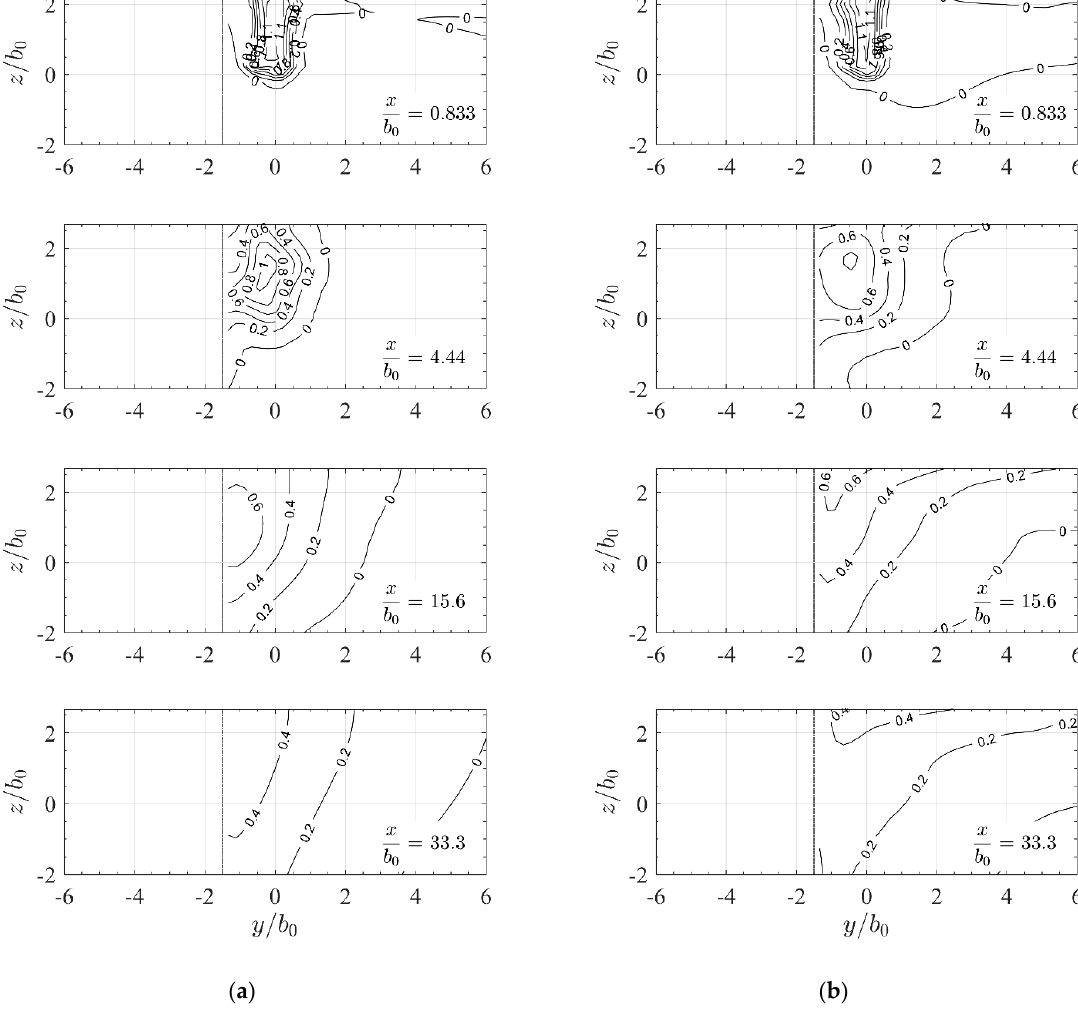
Figure 15. Slot jet with inhomogeneous approach flow and wall distance equal to b 0 showing isolines of the normalized, time-averaged, streamwise velocity component in yz-sections with relative distances to the orifice as simulated for ( a ) siw-rans and ( b ) siw-des . The wall is situated at y / b 0 = − 1.5 and the wall distance equals the slot